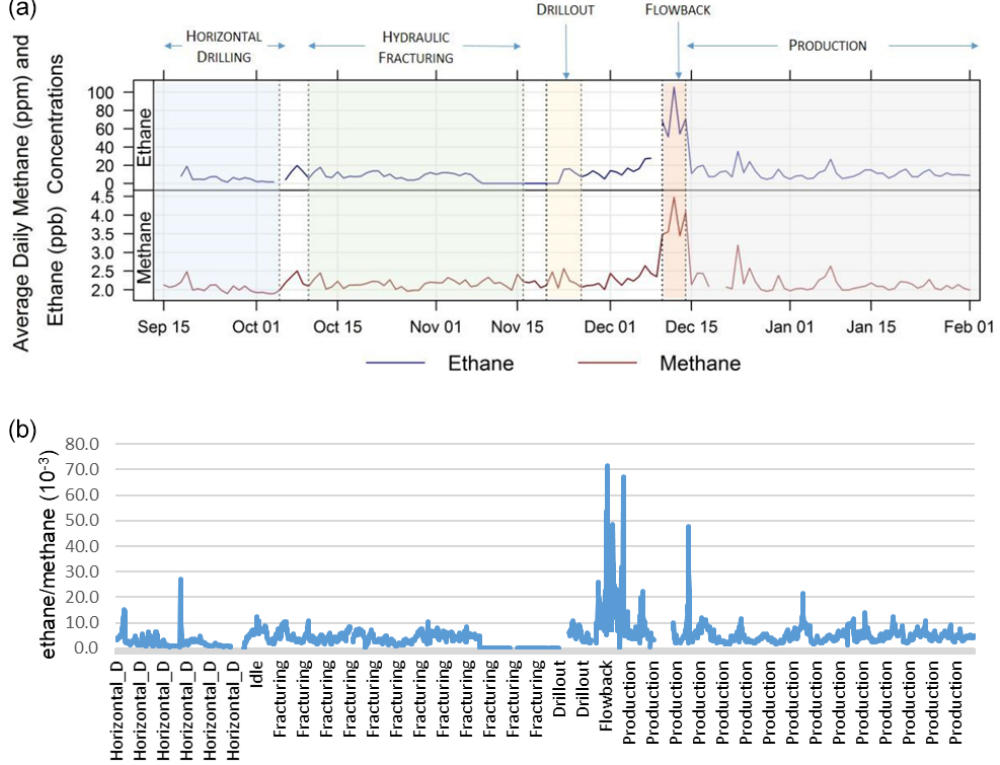
Figure 4. (a) Ethane and methane 24h average concentrations and (b) the ratio of ethane to methane from drilling through the production monitoring period of well pad activity.